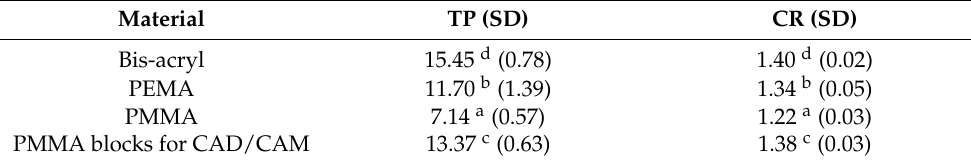
Table 5. Mean of initial (T0) translucency parameter (TP) and contrast ratio (CR) by material. Material TP (SD) CR (SD) Bis-acryl 15.45 d (0.78) 1.40 d (0.02) PEMA 11.70 b (1.39) 1.34 b (0.05) PMMA 7.14 a (0.57) 1.22 a (0.03) PMMA blocks for CAD/CAM 13.37 c (0.63) 1.38 c